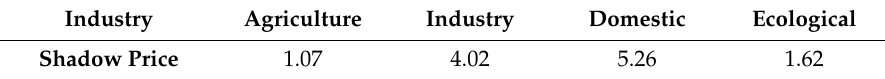
Table A5. The shadow prices of di ff erent industries